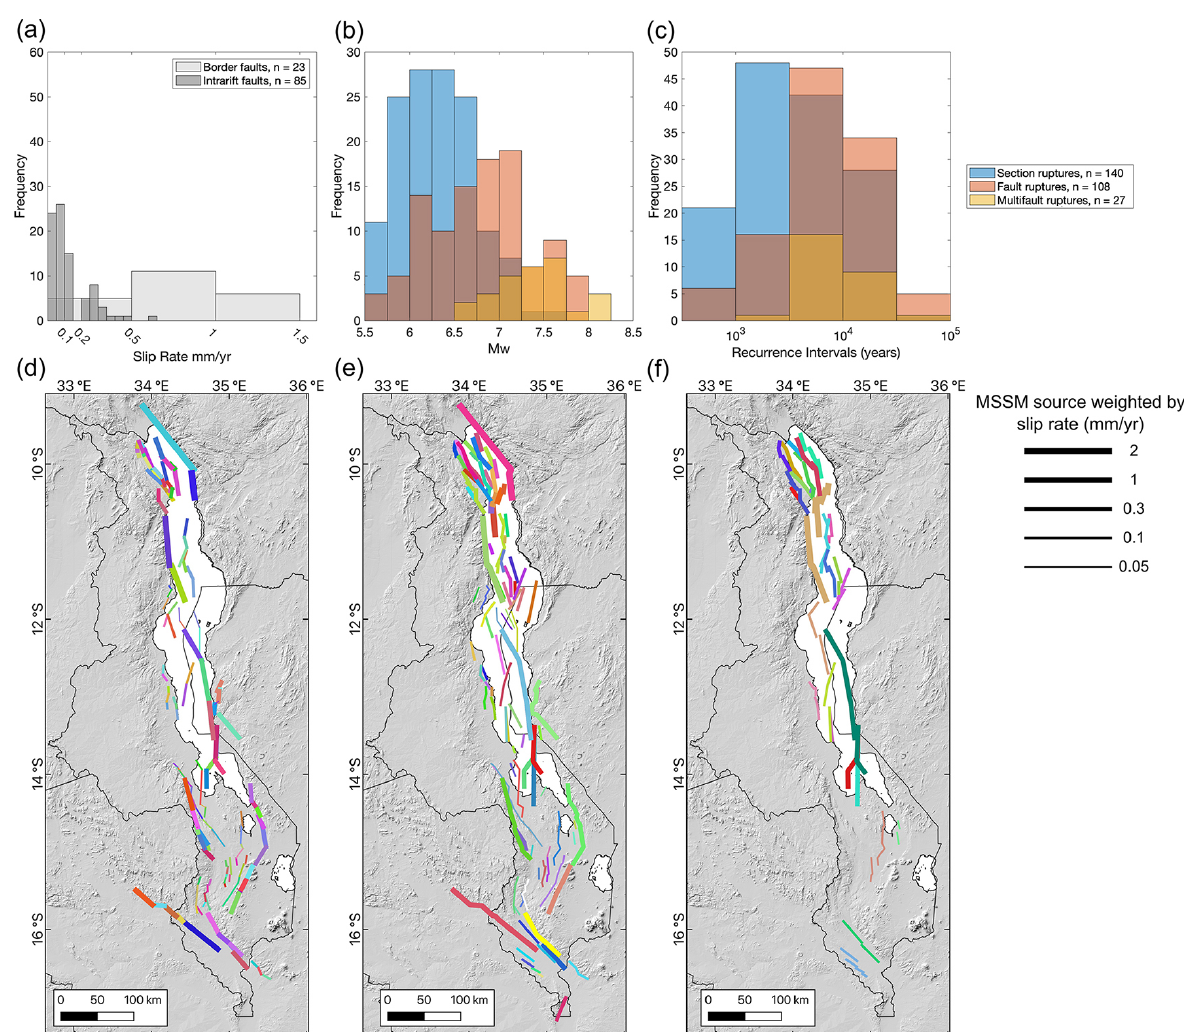
Figure 8. Histograms for intermediate estimates of (a) fault slip rates, (b) magnitude estimates, and (c) recurrence intervals in the Malawi Seismogenic Source Model (MSSM). Maps of the (d) section, (e) fault, and (f) multifault sources in the MSSM, with lines weighted by the source’s intermediate slip rate estimate. Each colour represents a different